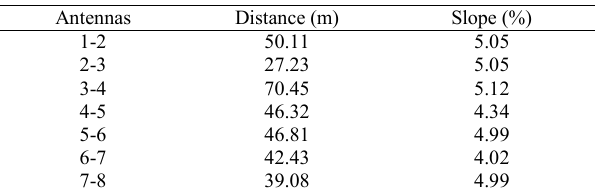
Table 1. Distance (m) and slope (%) among antennas along fish ladder of Porto